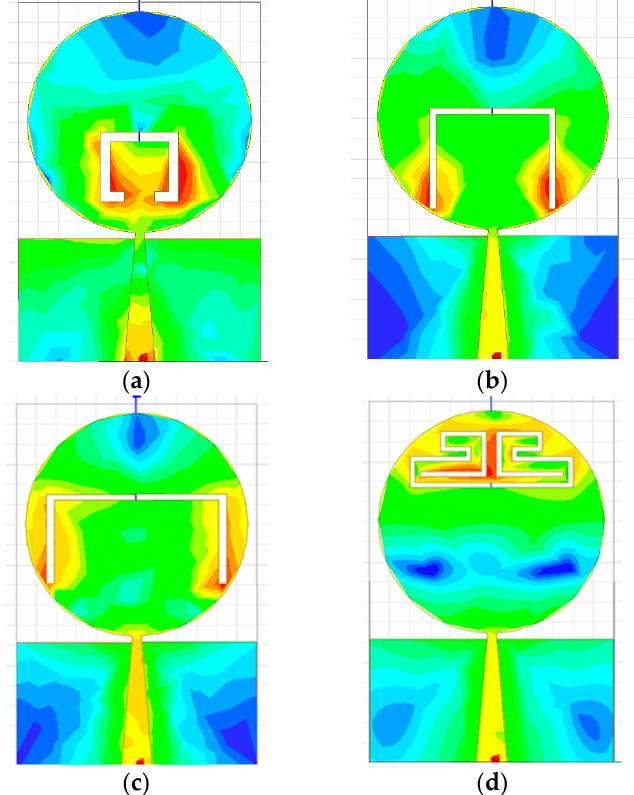
Figure 5. Simulated current distribution at frequency: ( a ) 10.5 GHz, ( b ) 7.5 GHz, ( c ) 5.5 GHz, ( d ) 3.5 GHz.